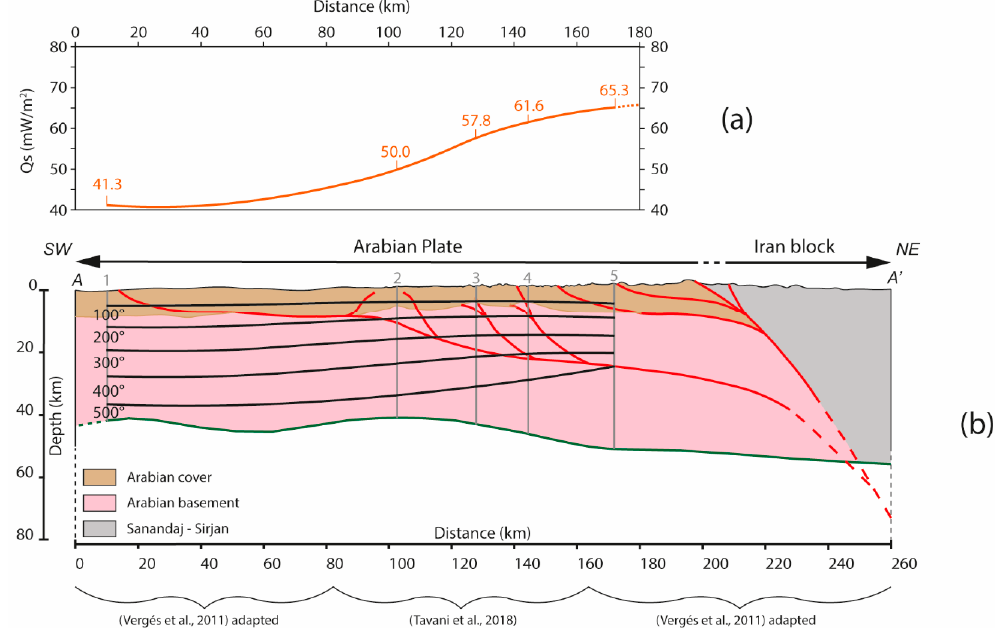
Figure 5. ( a ) Surface heat flow (Qs) curve calculated using the five vertical lines of our model (refer to Figure 3). ( b ) Thermal structure of Zagros Mountains of western Lurestan as defined by isotherms produced by interpolation among the vertical lines.